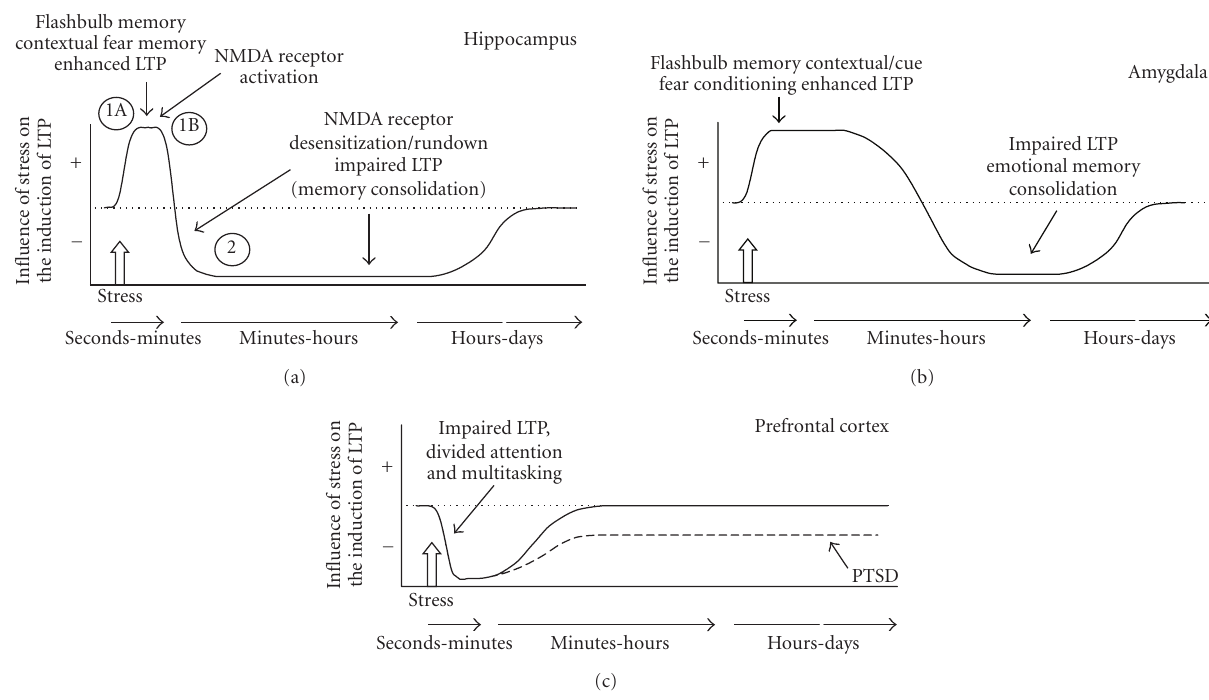
Figure 3: Temporal dynamics model of how stress a ff ects memory-related processing in the hippocampus, amygdale, and prefrontal cortex. The initiation of a strong emotional experience activates memory-related neuroplasticity in the hippocampus and amygdala, and suppresses PFC functioning (phase 1). The most rapid actions would involve increases in ACTH, CRF, NE, acetylcholine, dopamine, and changes in GABA receptor binding (phase 1A), followed within minutes by elevated levels of glucocorticoids (phase 1B). The combination of the activation of the hippocampus by these neuromodulators with coincident tetanizing stimulation produces a great enhancement of LTP. Within minutes of the initiation of phase 1, the hippocampus undergoes a reversal of its plasticity state, based, in part, on the reduction in the sensitivity of NMDA receptors (phase 2). Tetanizing stimulation delivered to the hippocampus during phase 2 will thereby result in an impairment of the induction of LTP. The amygdala continues in its form of phase 1 longer than the hippocampus, but eventually, the amygdala, as well, exhibits an inhibitory phase, perhaps as it is involved in the consolidation of the emotional memory. The PFC is only inhibited by stress; the recovery from its suppression of functioning would depend on the nature and intensity of the stressor, interacting with the ability of the individual to cope with the experience. In the case of trauma-induced PTSD, the PFC may not recover to its original state of e ffi ciency in suppressing the activity of lower brain areas, such as the amygdala and brain stem